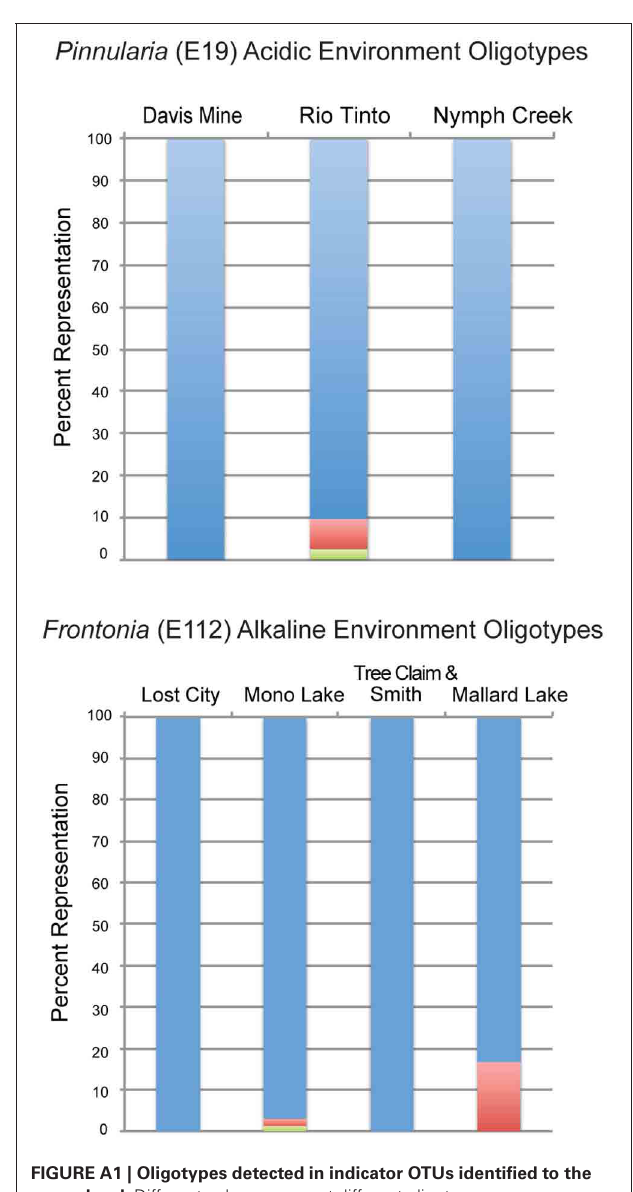
FIGURE A1 | Oligotypes detected in indicator OTUs identified to the genus level. Different colors represent different oligotypes.